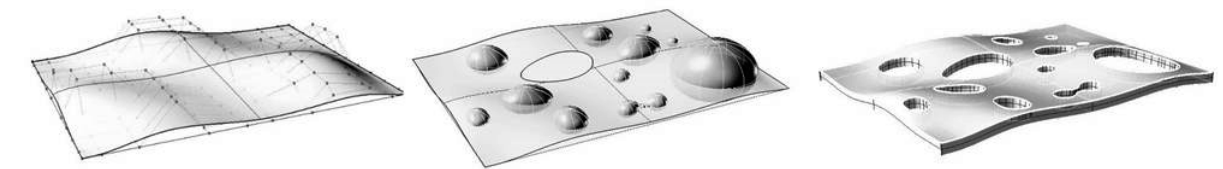
Figure 6. Modelling (step by step) the geometry of the free surfaces with Rhinoceros CAD software - initial concept design.